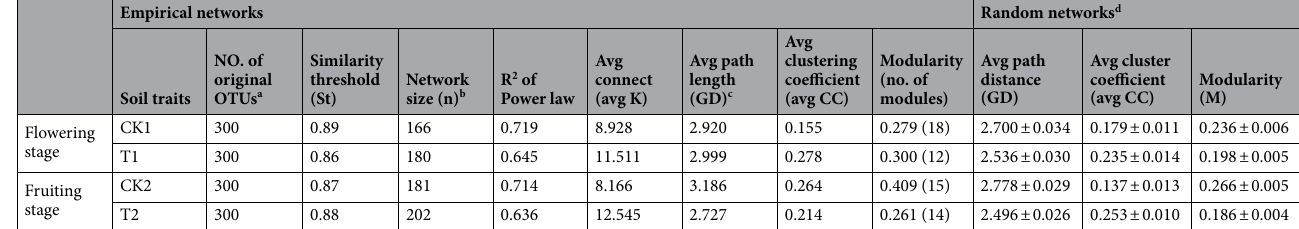
Table 1. Major topological properties of the empirical phylogenetic Molecular Ecological Networks (pMENs) of fungal communities for soil with (T1 and T2) and without (CK1 and CK2) wheat straw addition and their associated random pMENs. a The number of OTUs that were originally used for network construction using the random matrix theory (RMT)-based approach. b The number of OTUs (i.e., nodes) in the network. c GD geodesic distance. d The random networks were generated by rewiring all of the links of a pMEN with the identical numbers of nodes and links to the corresponding empirical pMEN.